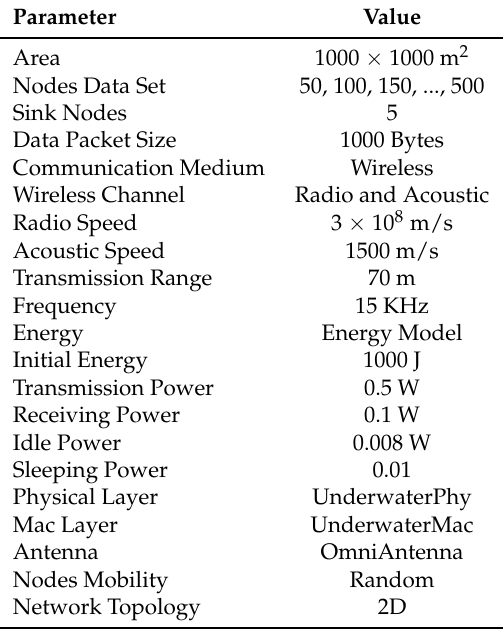
Table 4. Simulation Setting.